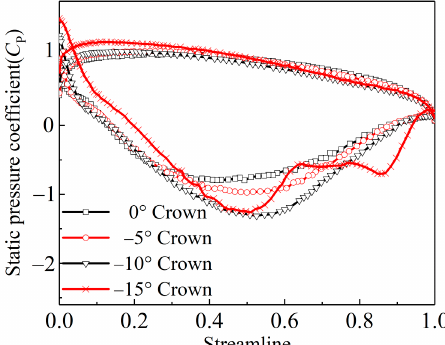
Figure 14. Pressure on the suction surface for six different blade lean angles: ( a ) 10°; ( b ) 5°; ( c ) 0°; ( d ) − 5°; ( e ) − 10°; ( f ) 15°. Runner with blade lean angles of 0°, − 5°, − 10°and − 15° are shown in Figure 15, in which the suction surface pressure decreases from 0° to − 10°. And when the blade lean angle is − 15°, the pressure fluctuates strongly in the middle and posterior parts, which lead to an obvious lower speed zone at the runner outlet compared with the runner with blade lean angle of 0° (Figure 16).